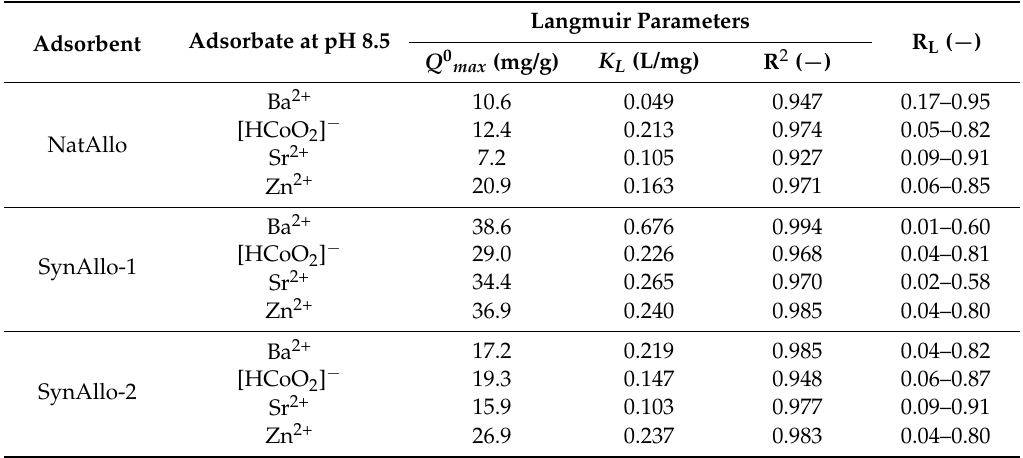
Table 2. Langmuir isotherm parameters and separation factor ( R L ) for the adsorption of aqueous Ba, Co, Sr, and Zn by natural and synthetic